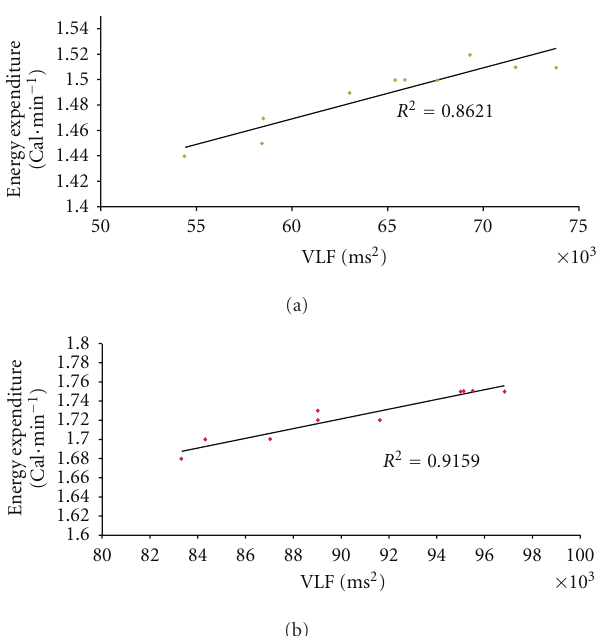
Figure 2: Correlation of very-low-frequency spectral power of heart rate variability with resting energy expenditure. Linear regression for raw (ms 2 ) units of very-low-frequency (VLF) power computed from fast Fourier transform analysis of electrocardio- gram RR intervals for ten healthy 18–20-year-old African American males during 20 min trials of uncontrolled breathing (a) and paced breathing at 0.2Hz (b) after metabolic provocation with a 900Cal test beverage. R 2 = . 86 and . 92; P < . 001, 8 df, respectively.